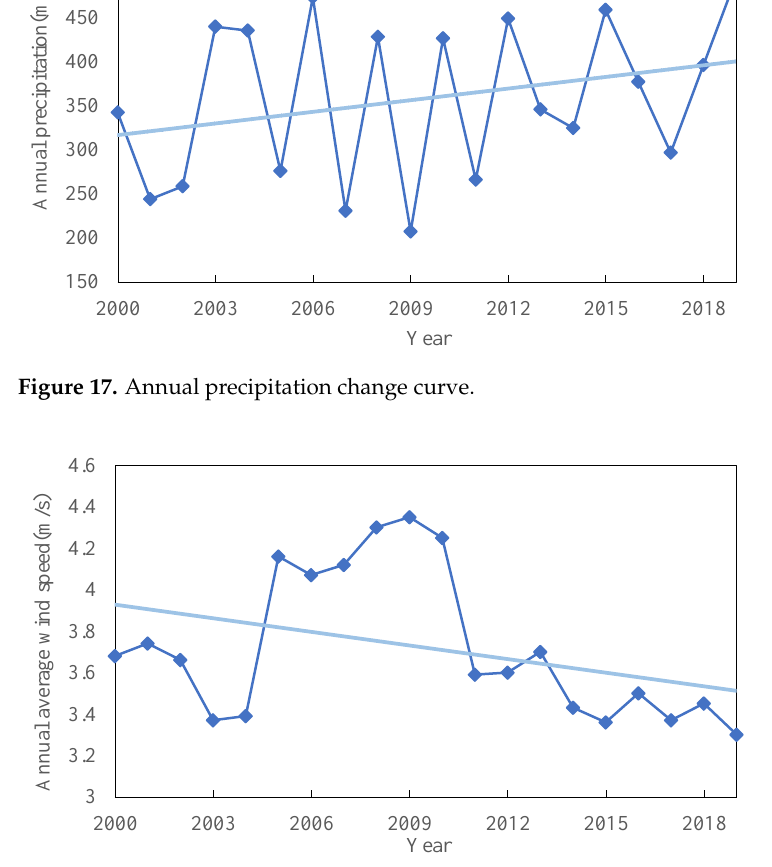
Figure 18. Annual average wind speed change curve.